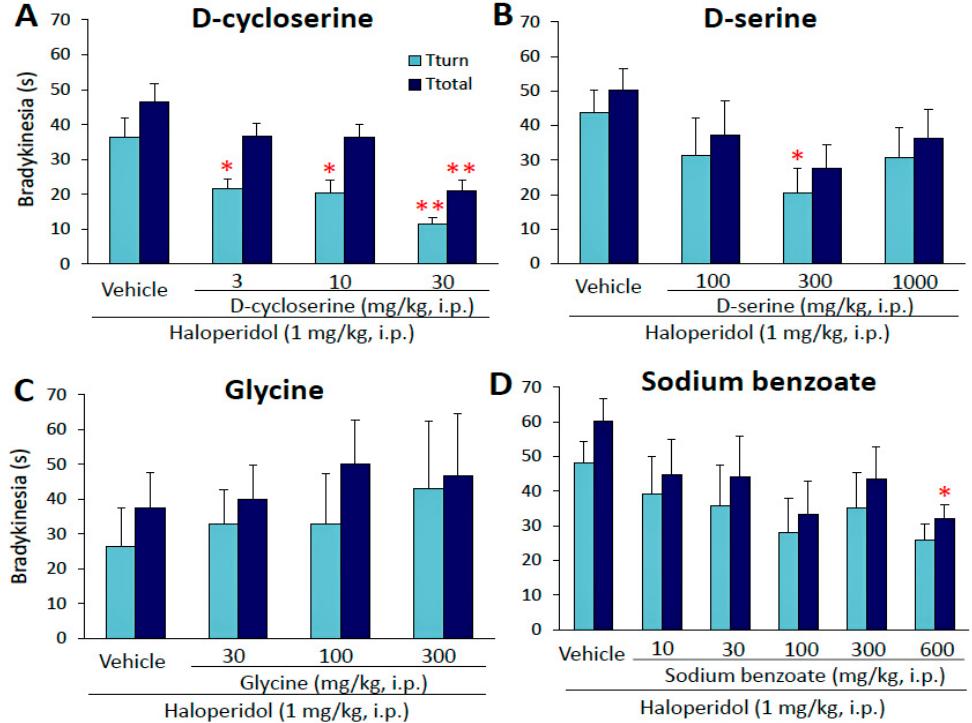
Figure 1. Effects of glycine-site agonists of N -methyl- D -aspartate (NMDA) receptors and the D -amino acid oxidase inhibitor on haloperidol (HAL)-induced bradykinesia. ( A – D ) Glycine-site agonists of NMDA receptors, D -cycloserine (3–30 mg/kg, i.p.), D -serine (100–1000 mg/kg, i.p.), and glycine (30–300 mg/kg, i.p.), and the D -amino acid oxidase inhibitor, sodium benzoate (10–600 mg/kg, i.p.), were administered to animals 15 min before the HAL injection. The pole test was performed 30 min after the HAL injection. Each column represents the mean ± S.E.M. of 5–13 mice. These data were analyzed using the Kruskal − Wallis and Steel − Dwass tests. * p < 0.05, ** p < 0.01, significantly different from the value with HAL alone.